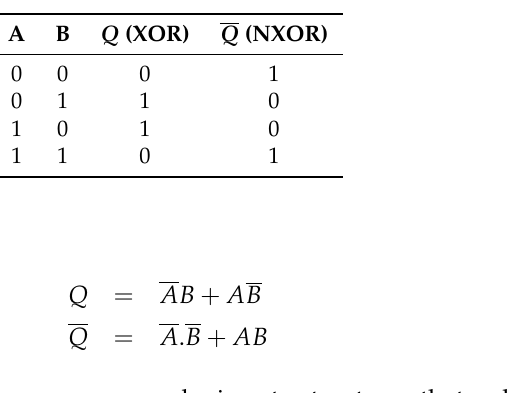
Table 4. Truth table of XOR/NXOR.